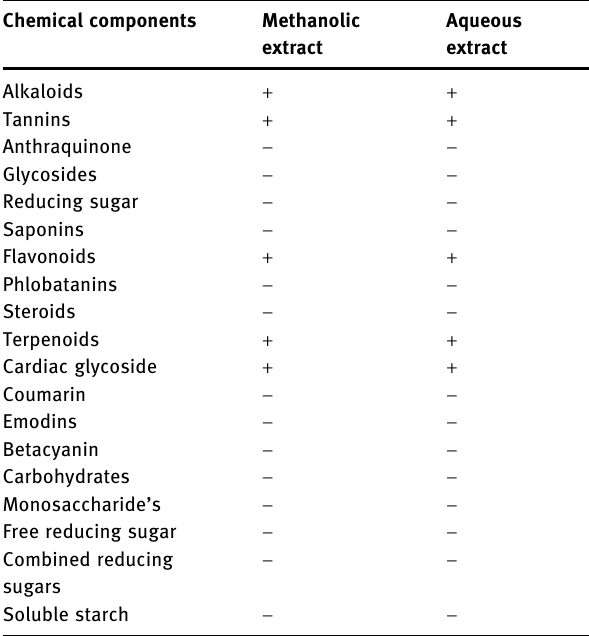
Table 1: Phytochemical analysis of aqueous and methanolic extracts of Tropaeolum majus Chemical components